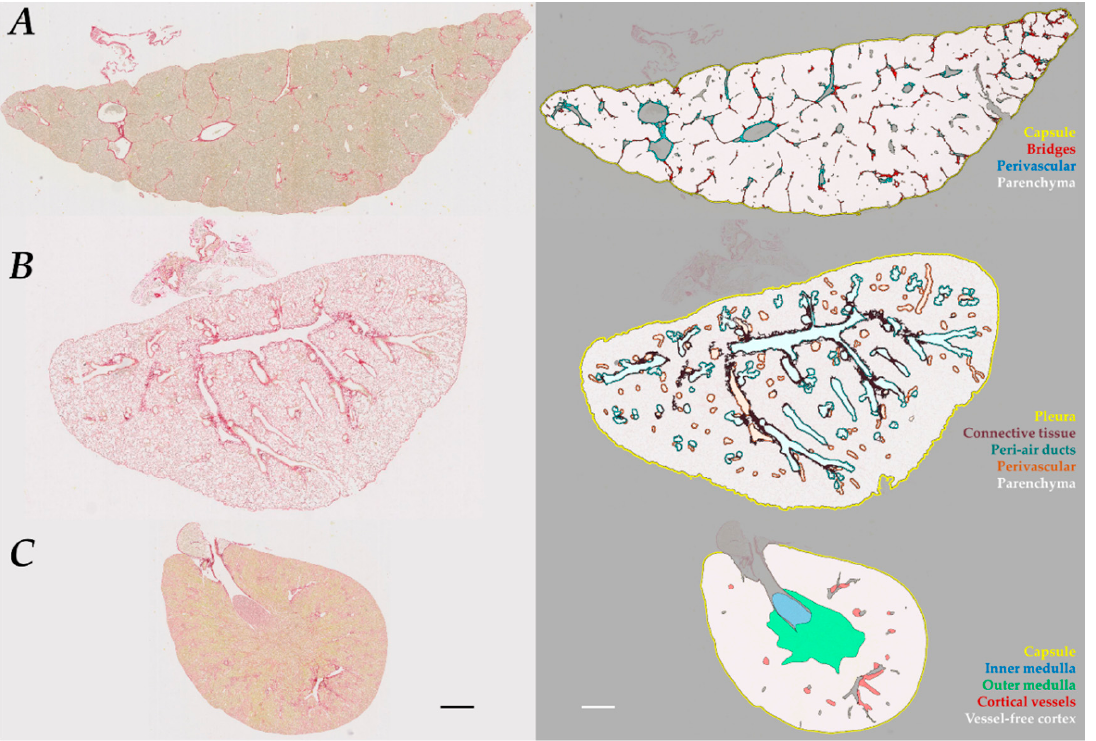
Figure 3. Computer-assisted segmentation of histological structures in the three studied organs. An illustration is given before ( left ) and after ( right ) semi-automated segmentation in ( A ) a 7w CCl 4 liver, ( B ) a BLM-chronic lung, and ( C ) a 4w CIS kidney. Details in Supplementary Material 1. Scale bar = 1 mm.